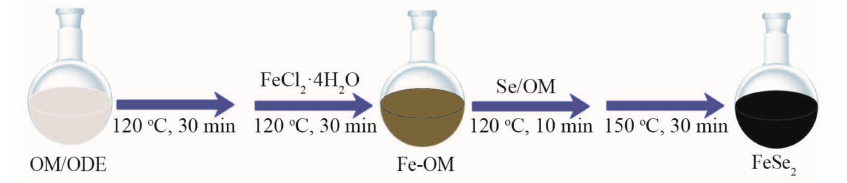
Figure 1. Synthetic route to FeSe 2 .